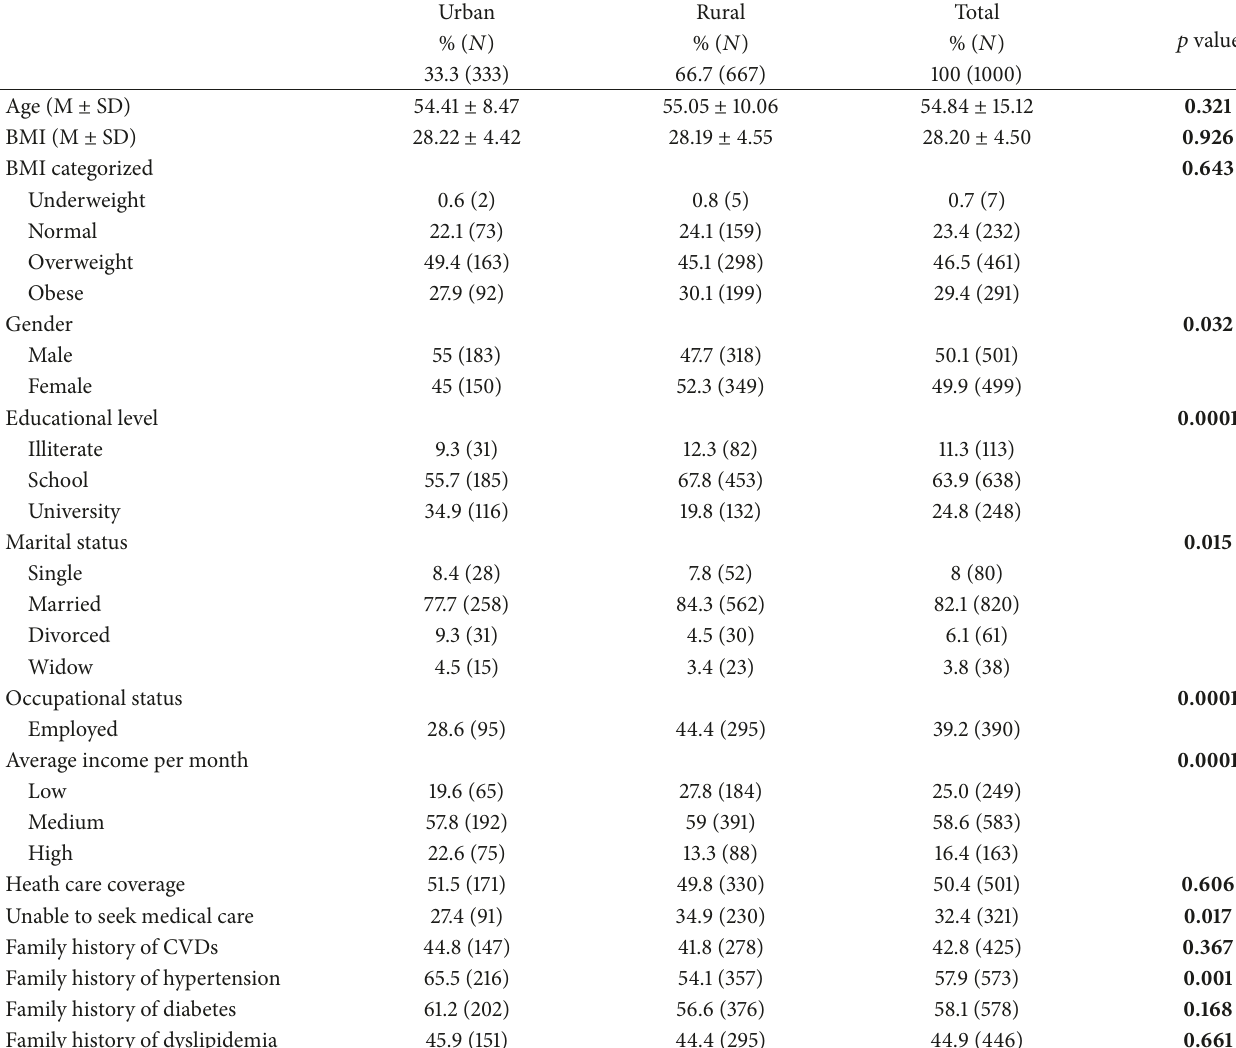
Table 1: Baseline characteristics of the study